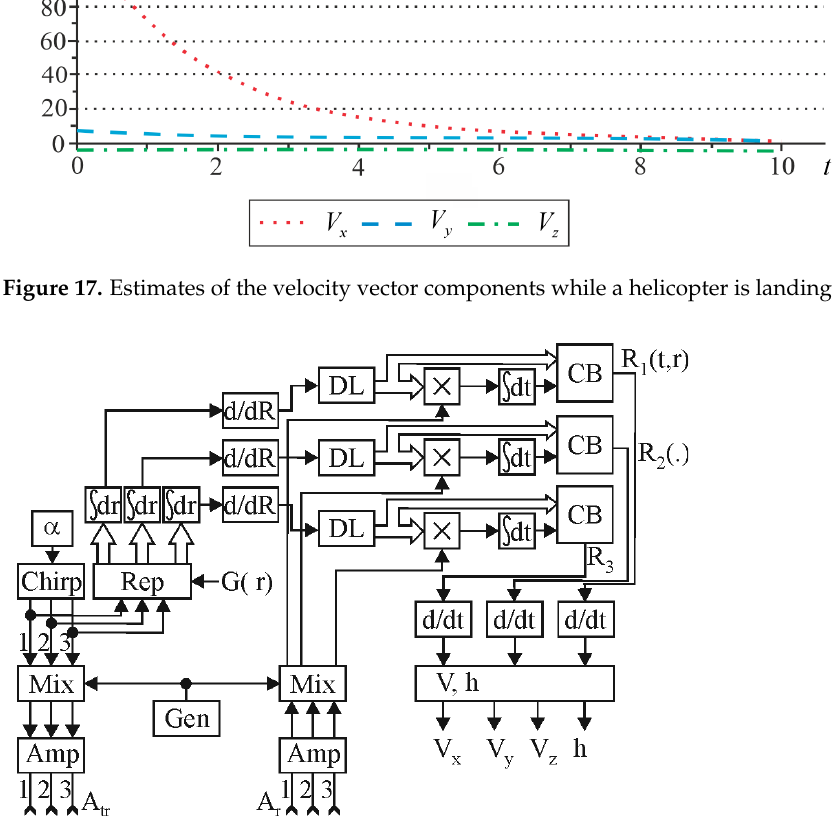
Figure 18. Structural diagram of the radar for the velocity vector components and altitude measure- ment.